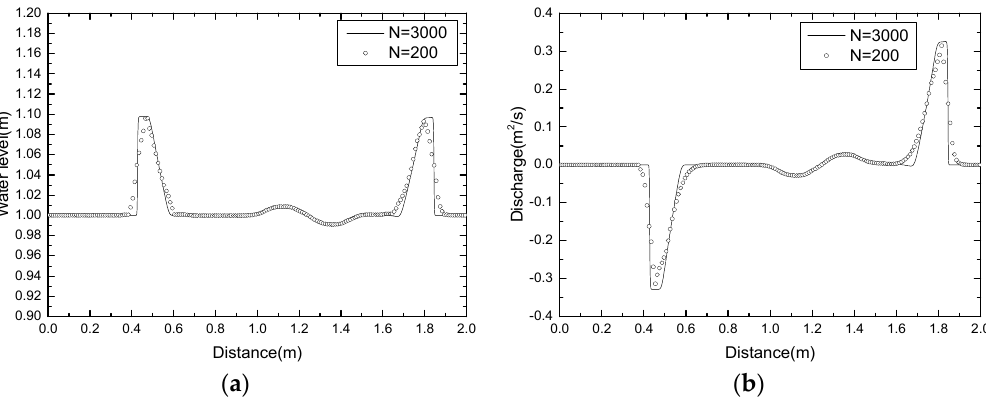
Figure 16. Small perturbation test with ε = 0.2 (big pulse) and time t = 0.2 s: ( a ) the water level; ( b ) the discharge.